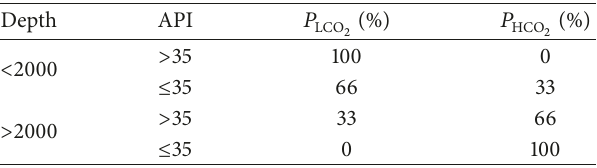
Table 2: Four EOR cases with different depth/pressure and API